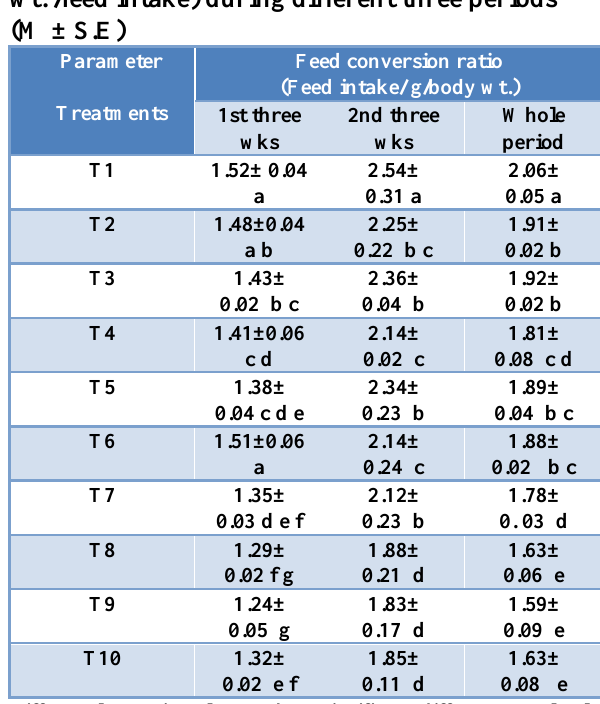
Table, 4: Effect of different levels of sweet basil powder on daily feed conversion ratio (g